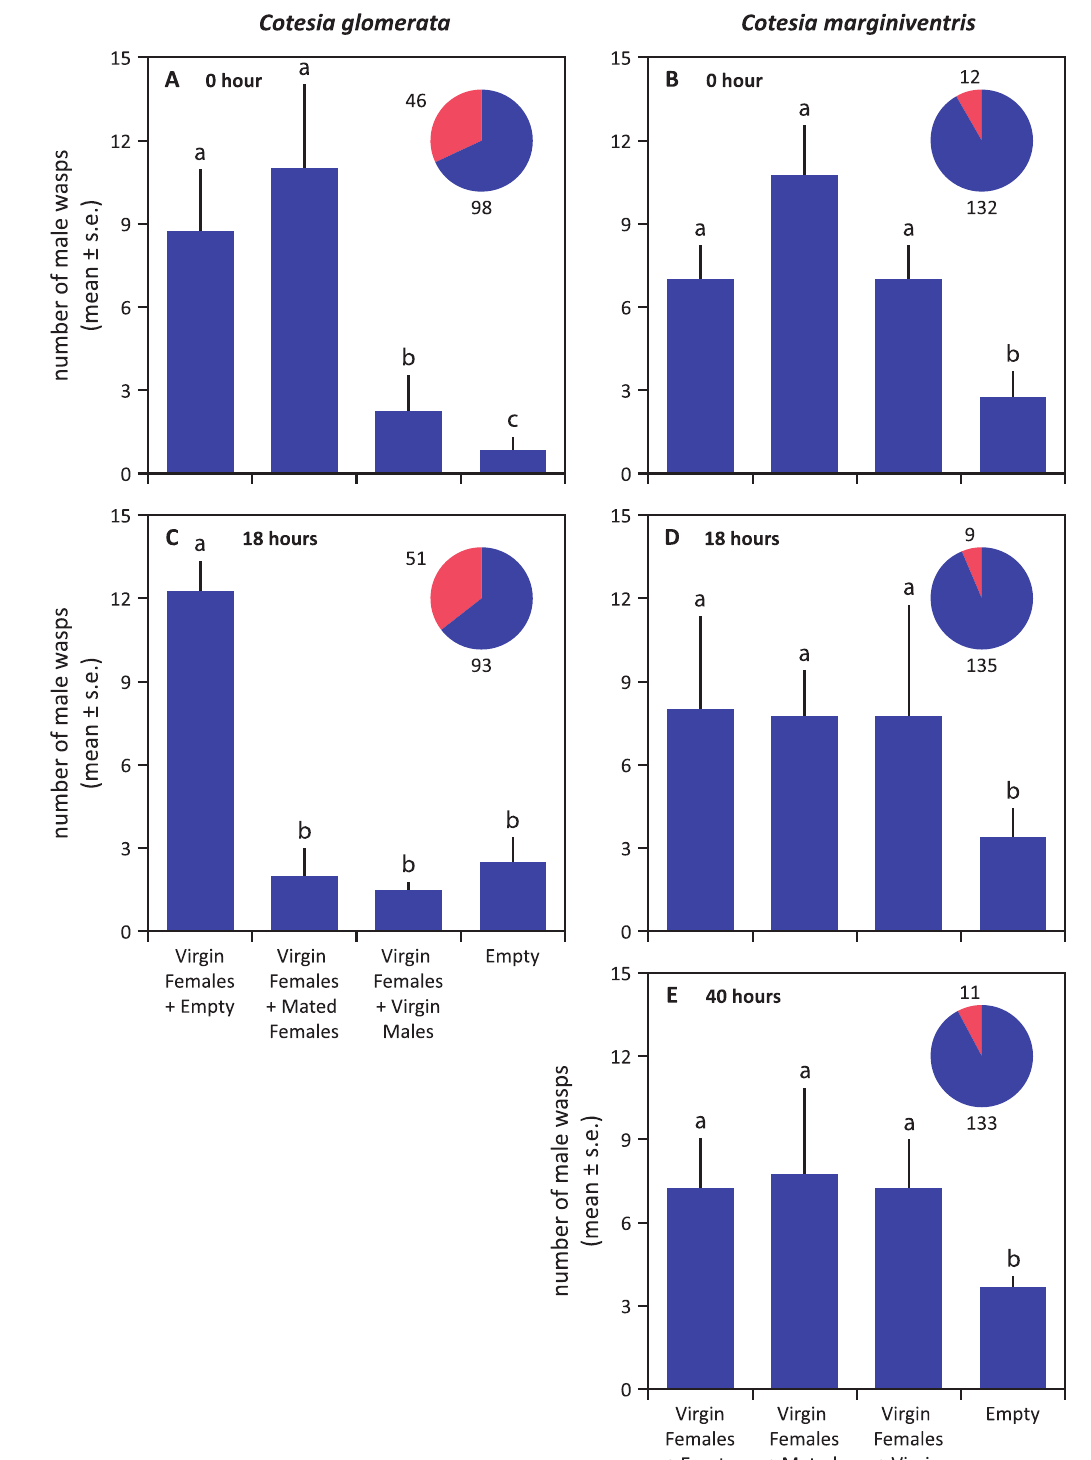
Figure 4. The six-arm olfactometer test for the repellency of mated females and of unmated males in the two parasitoid species, C. glomerata ( A , C ) and C. marginiventris ( B , D , E ), immediately ( A , B ), about 18 hours ( C , D ) and about 40 hours ( E ) after females had mated, respectively. The proportion of wasps that showed no response, i.e. , that did not choose an arm, is given in red in the pie chart, supplemented with the absolute numbers of wasps. Statistical differences ( p < 0.05) are indicated with different letters above the